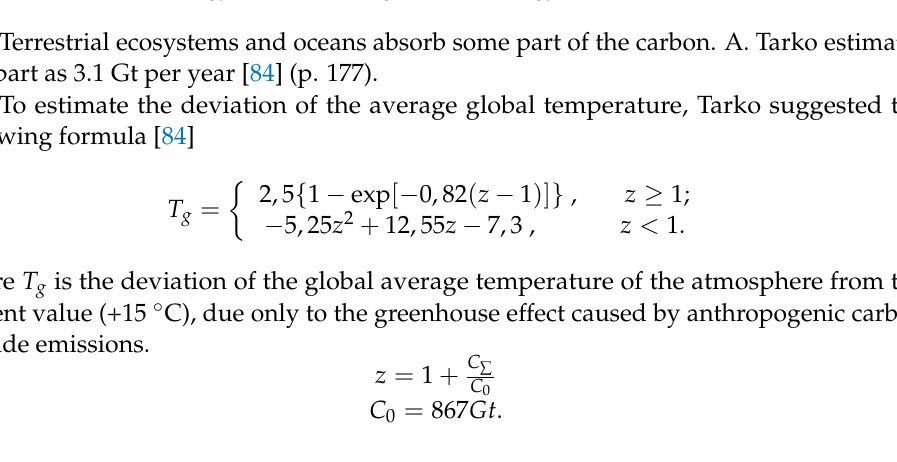
Figure 23. Dynamics of carbon accumulation in the Earth’s atmosphere in the 21st century under the ambitious scenario of energy transition using CCS technology.